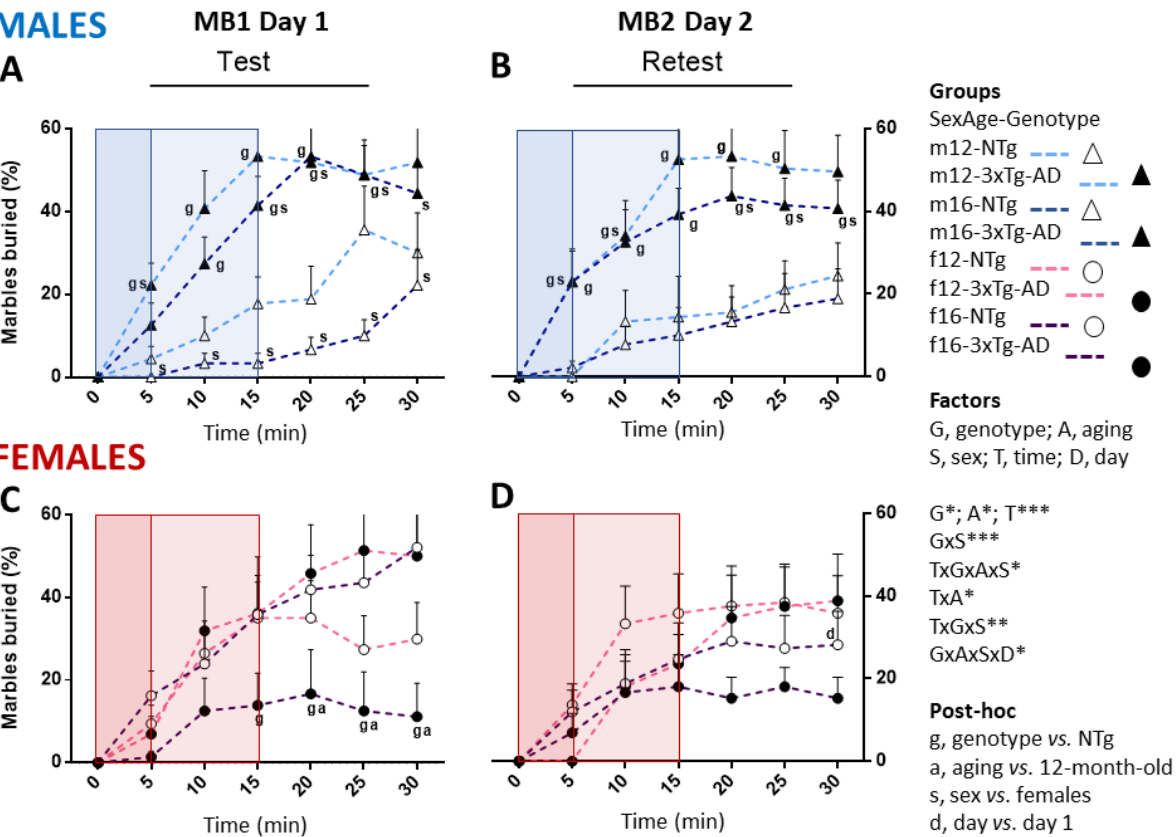
Figure 3. Sex, age, time, and day effects in the longitudinal assessment in the marble burying test and repeated test in mice with normal and AD-pathological aging. ( A ) Males marble burying test on day 1 (MB1 Day 1) and ( B ) re-test 24 h later (MB2 Day 2); ( C ) Females marble burying test on day 1 (MB1 Day 1) and ( D ) re-test 24 h later (MB2 Day 2); Factorial analysis: G, genotype (NTg, 3xTg-AD mice); A, aging (12, 16 months of age); S, sex (male, female); T, time (0–30 min); D, day (Day 1, Day 2). * p < 0.05; ** p < 0.01; *** p < 0.001.